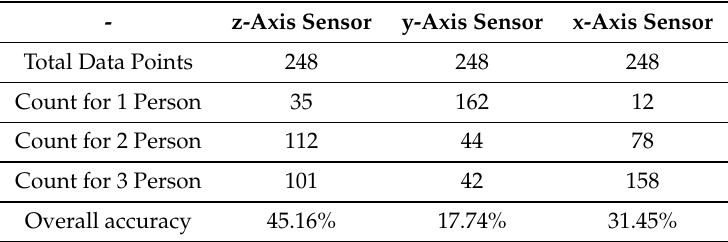
Table 4. Problem with different window sizes.